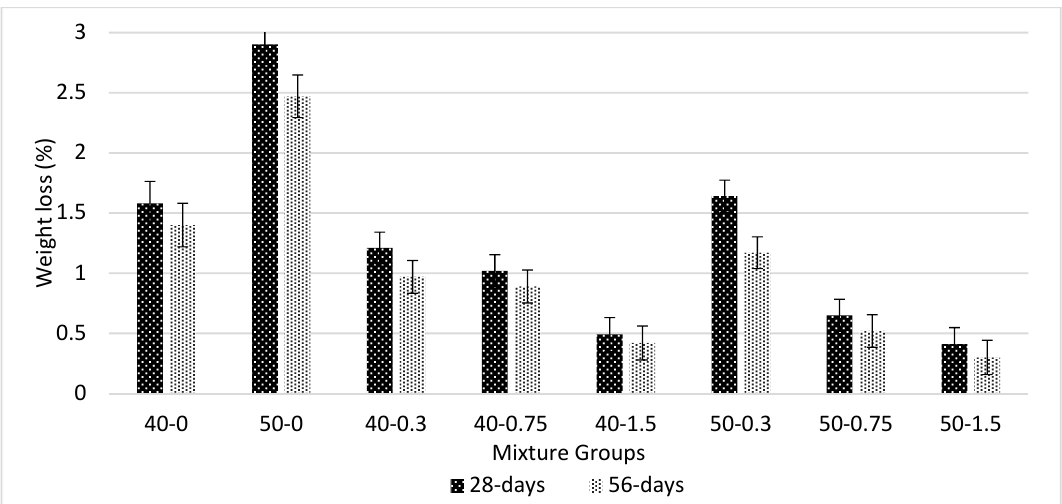
Figure 10. Seawater resistance test for basalt-reinforced bottom ash cement paste composites at 28 and 56 days of curing.